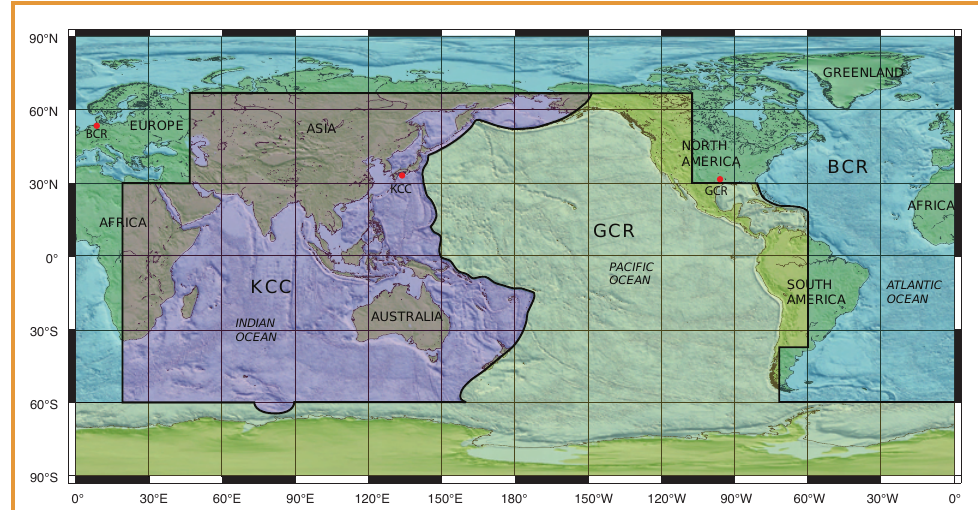
Figure 1. Map of geographic distribution of ocean drilling cores at the KCC, GCR, and